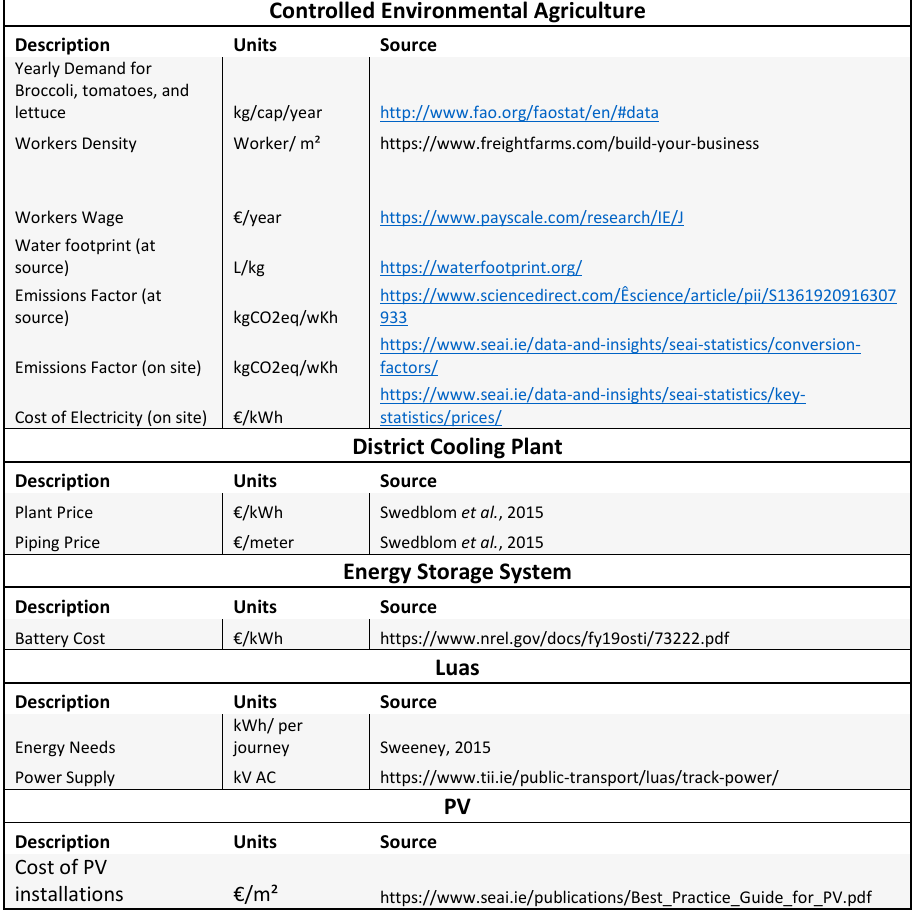
Figure A1. Sources used for estimating cost-, energy- and CO 2 -related savings are listed in the Appendix of this paper.